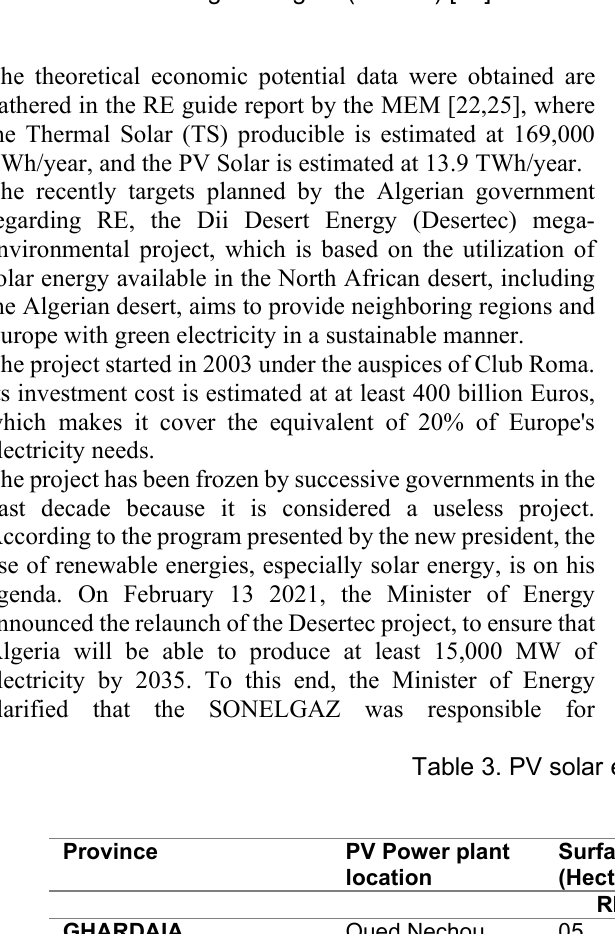
Figure 1. Potential for solar energy supply in the different Algeria region (Wh/m2) [24]